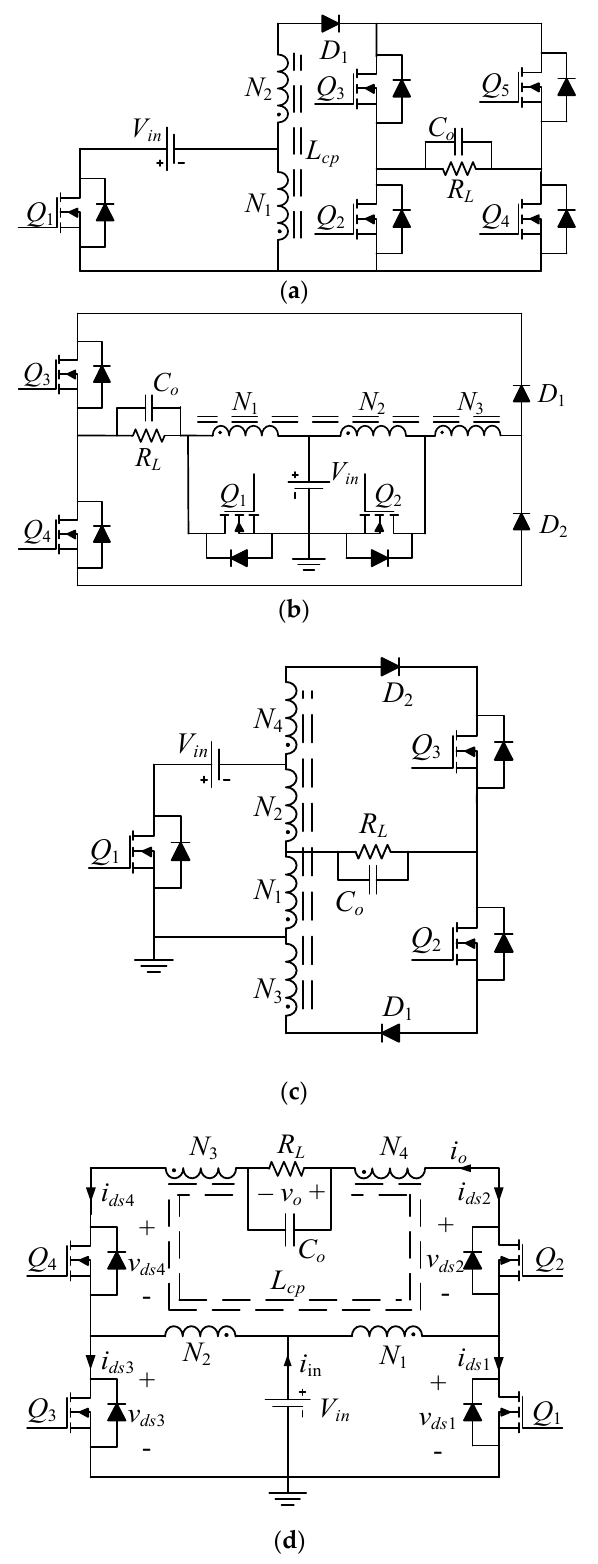
Figure 3. Proposed family of single-stage, buck-boost inverters: ( a ) Variant 1, ( b ) Variant 2, ( c ) Variant 3, ( d ) Variant 4 (SSBBI).